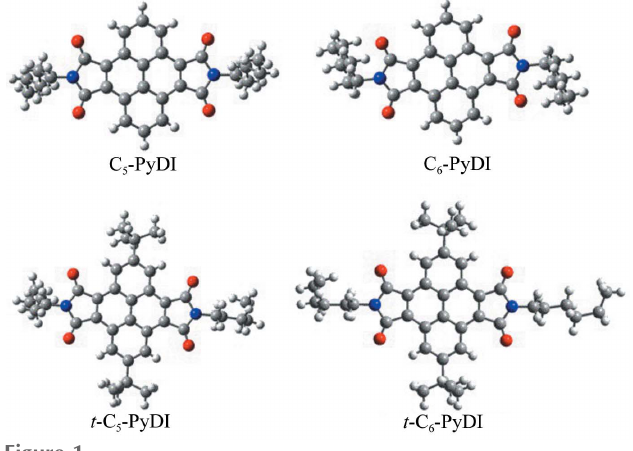
Figure 1 Molecular structures of C 5 -PyDI, C 6 -PyDI, t -C 5 -PyDI and t -C 6 -PyDI. Red: O; blue: N; gray: C; white: